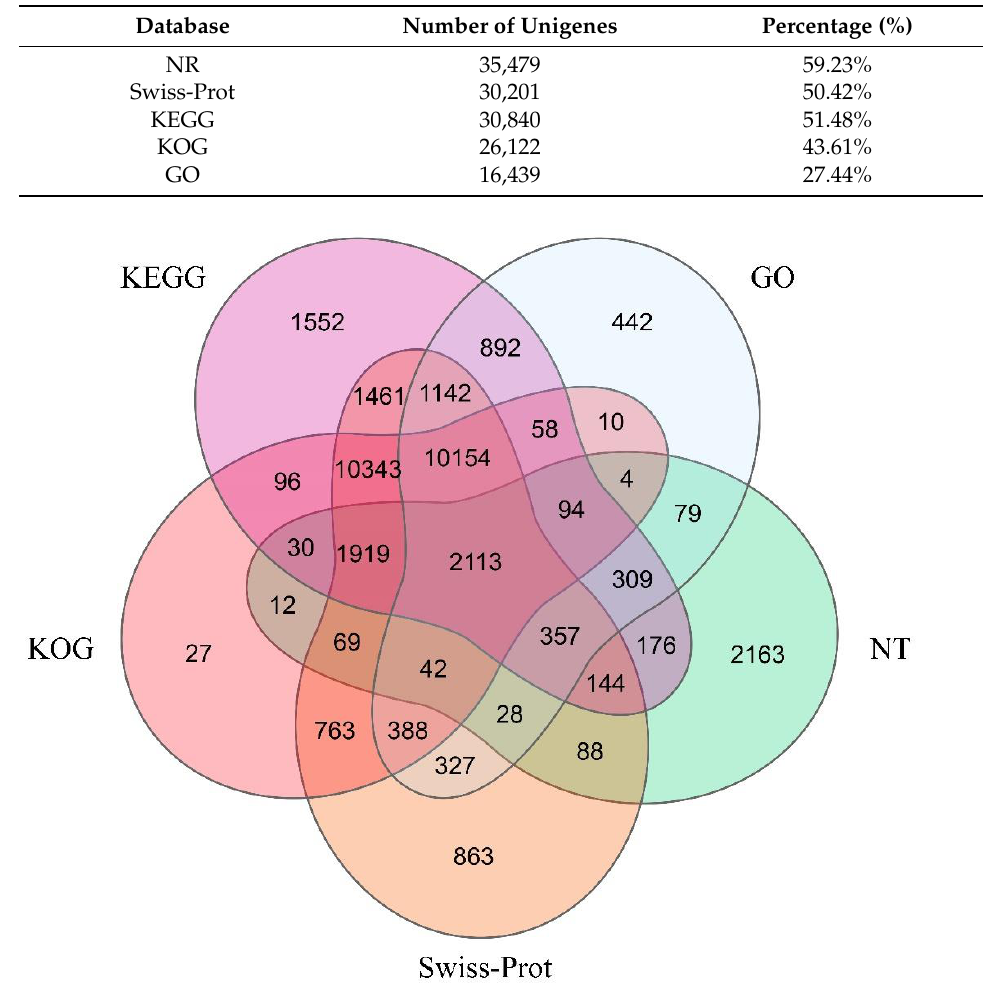
Figure 1. Venn diagram of the functional